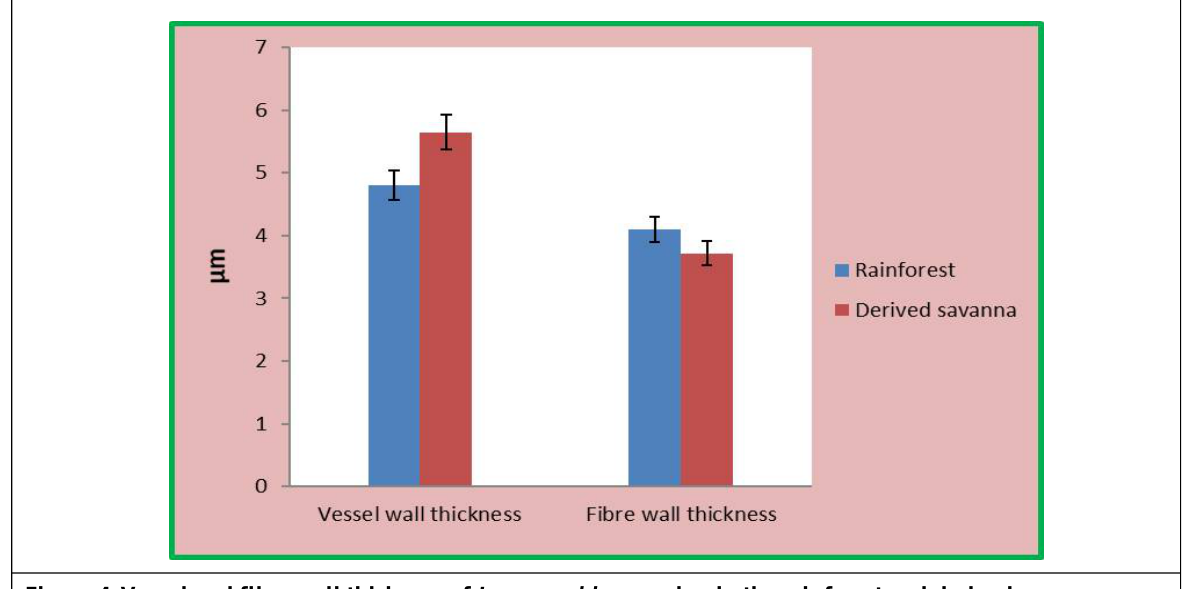
Figure 4: Vessel and fiber wall thickness of L. cupanoides growing in the rainforest and derived savanna regions of Edo state Table 1: Morphological characterization of vessel and fiber elements of Blighia sapida growing in rainforest and derived savanna regions of Edo